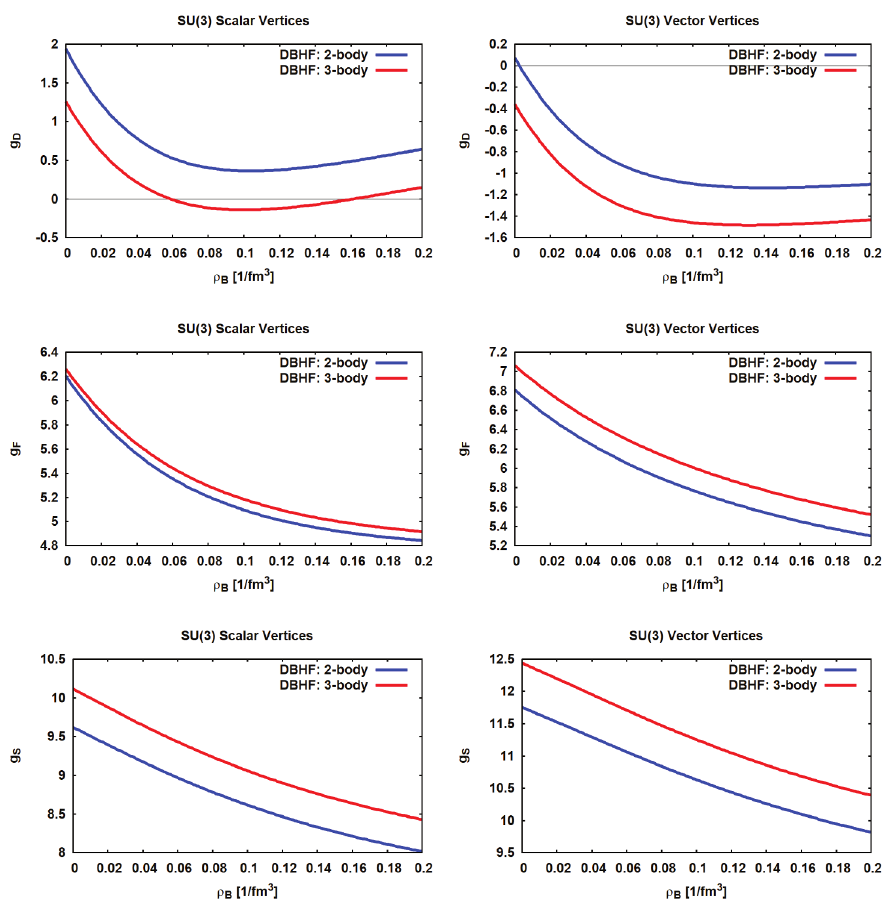
Figure 2. Elementary SU(3) in–medium scalar (left) and vector (right) vertices. In each column from top to bottom g D , g F and g S are displayed as functions of the baryon number density in symmetric nuclear matter. As indicated, results are shown without (blue) and with three–body (red) interactions, the latter are of Fujita–Miyazawa type [19] and act only among